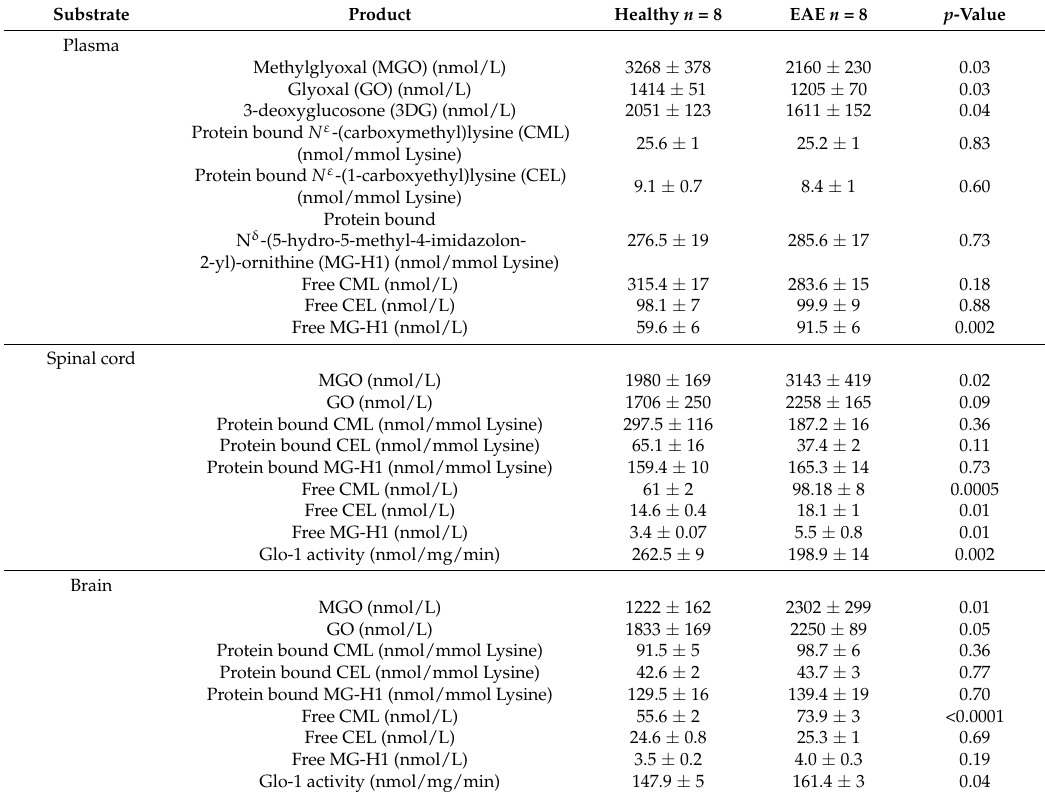
Table 1. Dicarbonyls and free advanced glycation endproducts (AGEs) in the plasma, spinal cord, and brain of mice subjected to experimental autoimmune encephalitis (EAE) and healthy